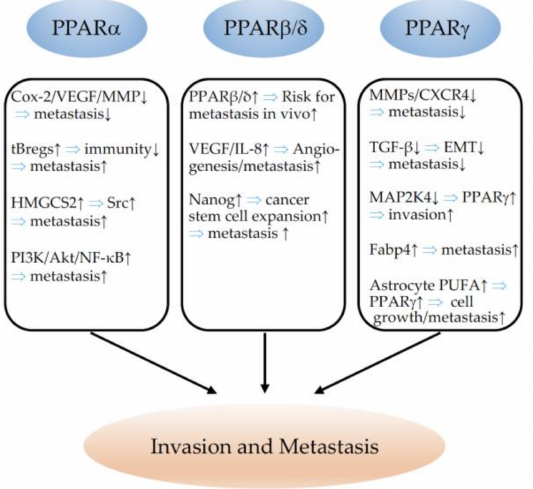
Figure 5. Schematic representation of the effects of PPAR α , PPAR β / δ , and PPAR γ on invasion and metastasis formation. ↓ indicates inhibition and ↑ indicates an increase. ⇒ : leads to; Cox-2: cyclooxygenase-2; VEGF: vascular endothelial growth factor; MMP: matrix metalloproteinase;